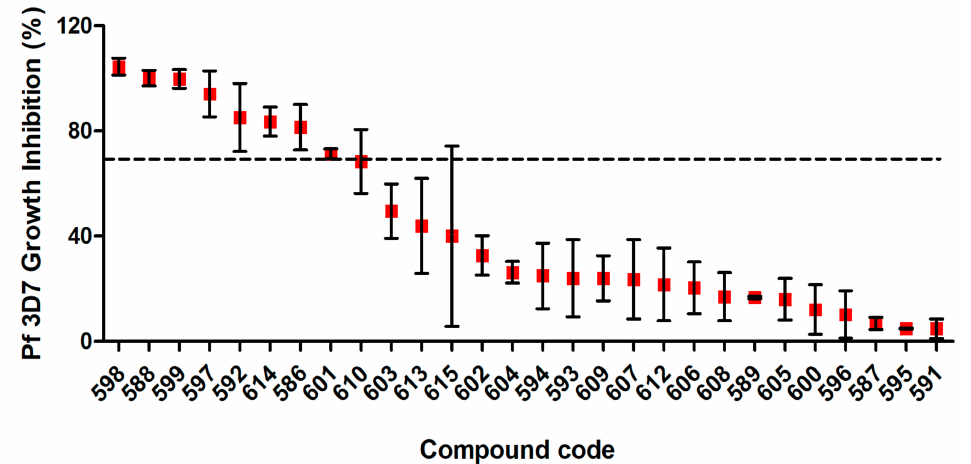
Figure 3. In vitro growth inhibition of asexual blood stage P. falciparum (3D7) for prioritized natural compounds and derivatives from virtual screening. The inhibitory potential of different compounds was tested at a concentration of 5 µ M and the inhibition of parasitemia was measured after 72 hours of incubation. The dashed line represents the cutoff used to highlight the most promising compounds above 70% of